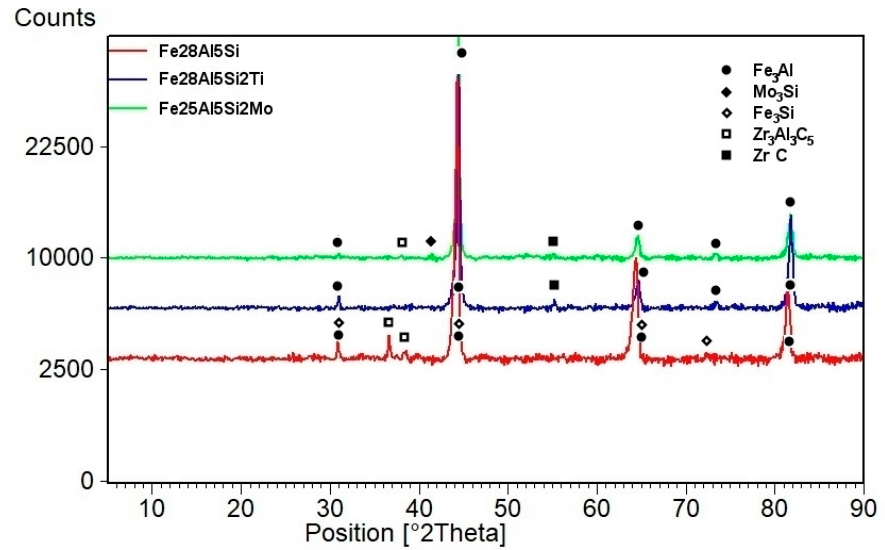
Figure 3. The evaluation of phases by XRD.